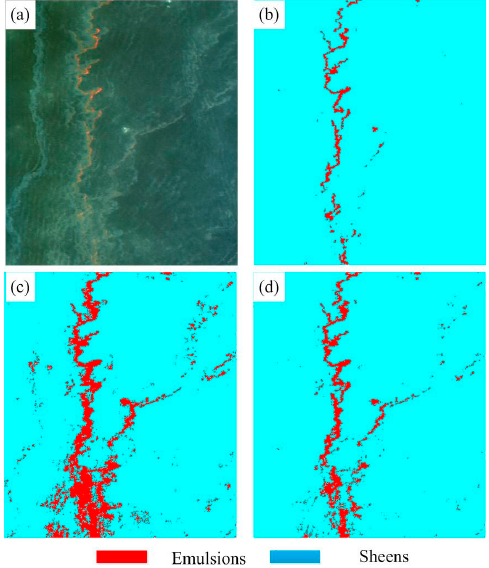
Figure 8. Images ( b – d ) are identification results for emulsions and sheens; red pixels represent identified emulsions, and cyan pixels represent sheens. Photo ( a ) is the original training image, and ( b – d ) are the identification results of FI (fluorescence index), RR (hydrocarbons), and CDOM (Colored Dissolved Organic Matter), respectively.